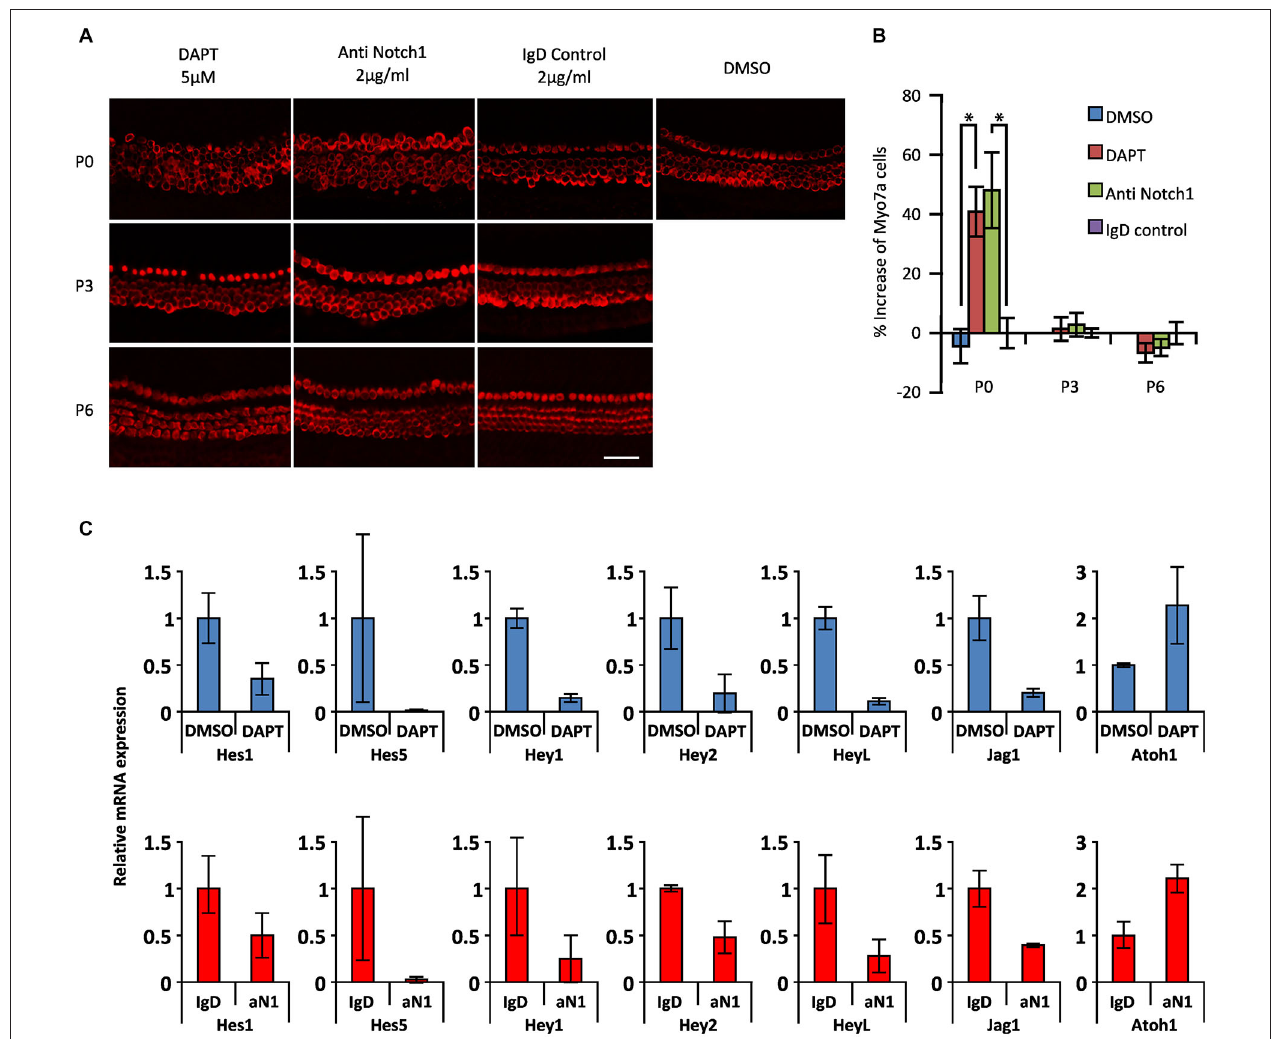
Anti Notch1/Control IgD comparisons respectively (Mann Whitney). Error bars: SEM. (C) mRNA amount of Notch pathway genes obtained by QPCR in whole cochlear explants of Atoh1 GFP transgenic reporter P0 newborn mice cultured in the presence of DAPT or DMSO and in Notch1 antibodies or control IgD antibodies. Blue columns (top): level of expression after DAPT treatment relative to DMSO. Red columns (bottom): level of expression after anti Notch1 antibodies (aN1) relative to control IgD antibodies. N = 3. Error bars: SEM. Note that error bars are present for each condition but are very small in some